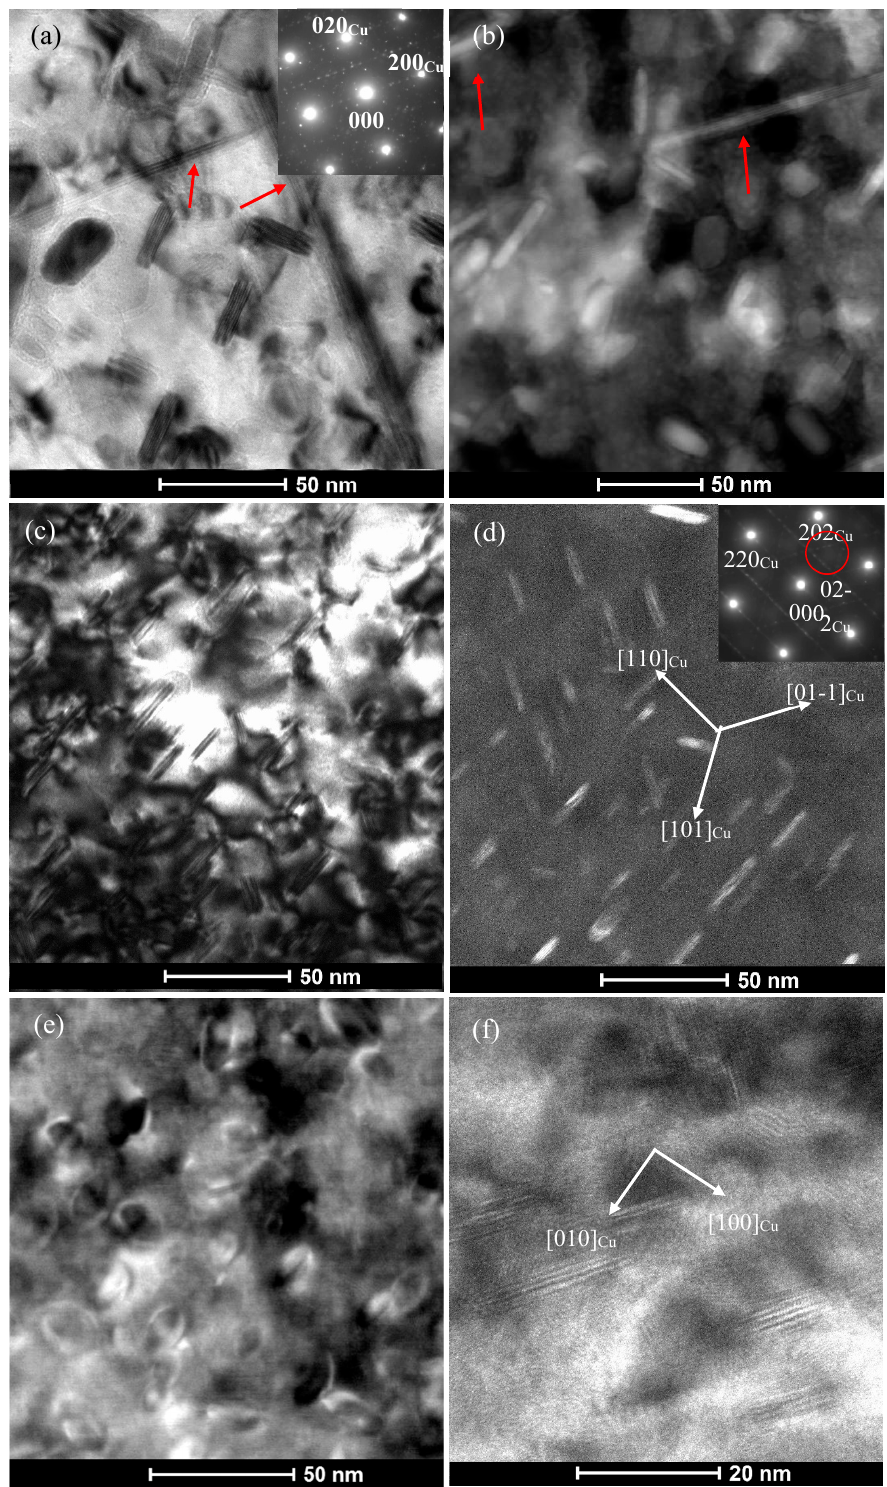
Figure 6. TEM images obtained from the C0, C1 and C4 alloys aged at 500 ◦ C for 16 h ( a ) BF image of C0 alloy along [001] Cu zone axis and corresponding SAED in the inset, ( b ) HAADF image of C0 alloy along [001] Cu zone axis, ( c ) BF image of C1 alloy along [ − 111] Cu zone axis, ( d ) DF image of C1 alloy and corresponding [ − 111] Cu pattern in the inset. DF image was taken using the reflections (marked by red circle) of precipitates. ( e ) HAADF image of C4 alloy, ( f ) HREM image of C4 alloy along [001] Cu zone axis. Red arrows in (a) and (b) refer to the P-rich